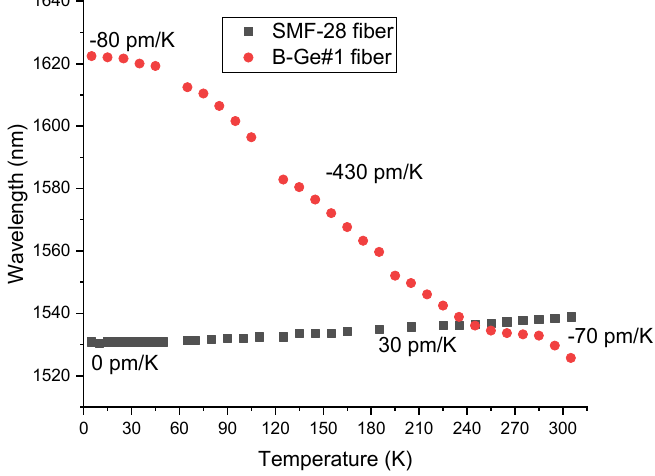
Figure 14. Temperature dependence of the resonance wavelengths of PS-LPFGs arc-induced in the SMF-28 and B/Ge#1 fibers. The average values of the temperature sensitivity are also indicated. Table 4. Typical temperature sensitivity values obtained using fiber gratings at low temperatures. Temp. Range Fiber